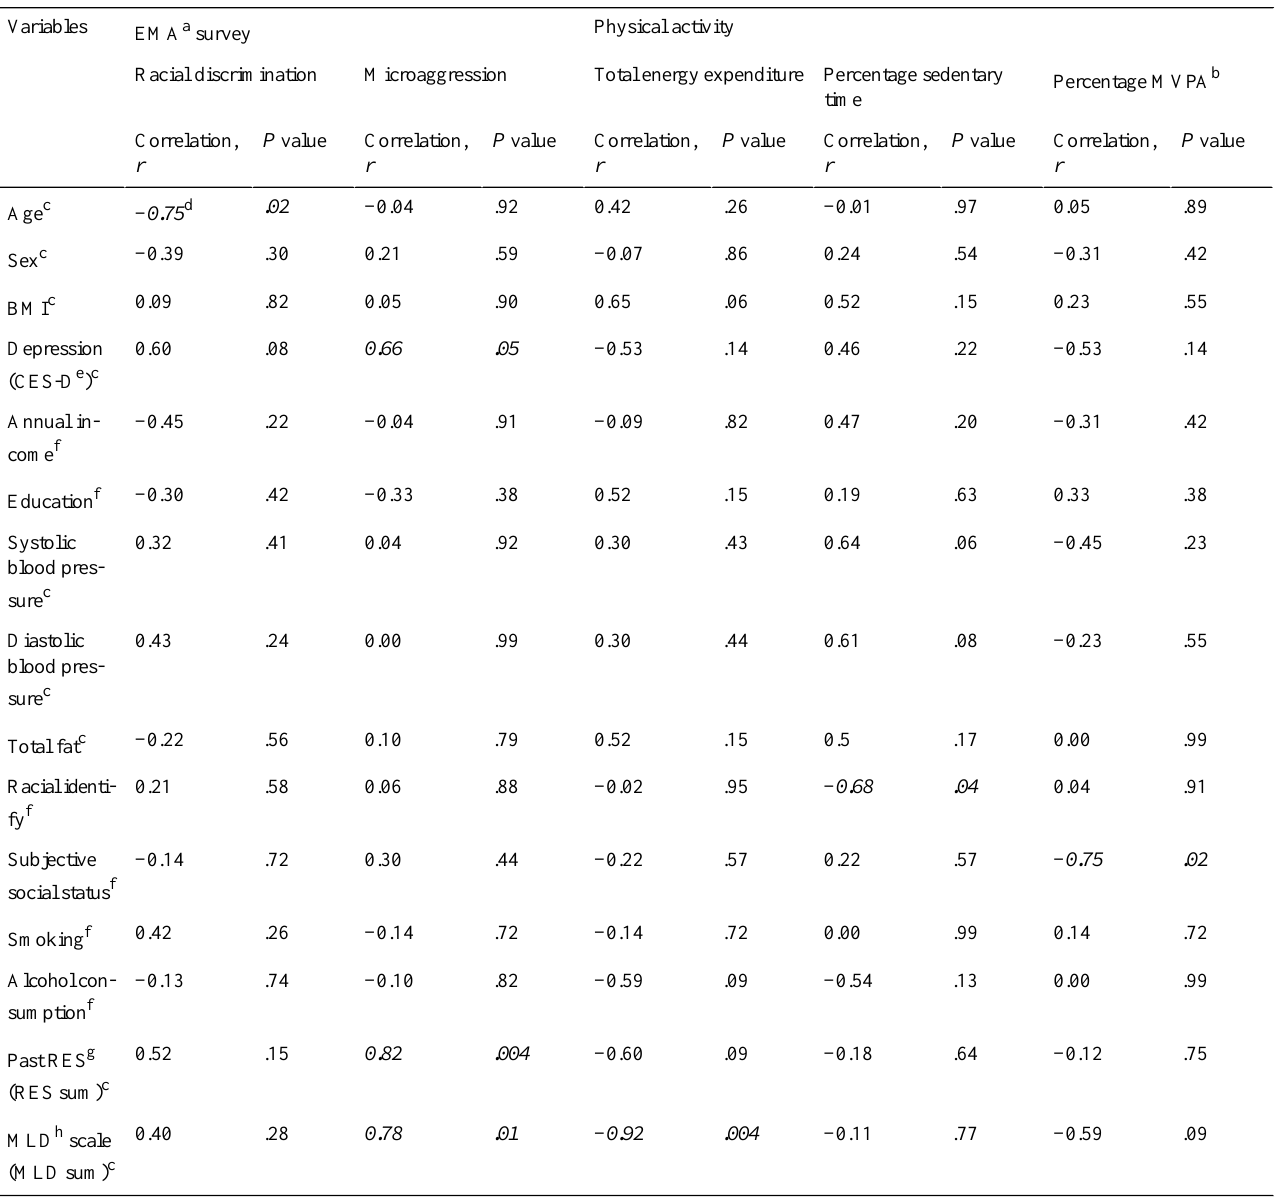
Table 2. Correlations between demographic characteristics and the average scores of the ecological momentary assessment survey or physical activity.